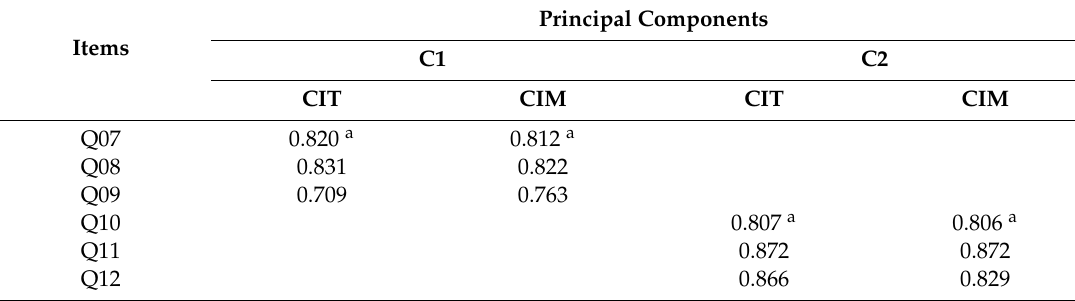
Table 14. Principal components analysis of the criteria related to project success (C1) and organization success